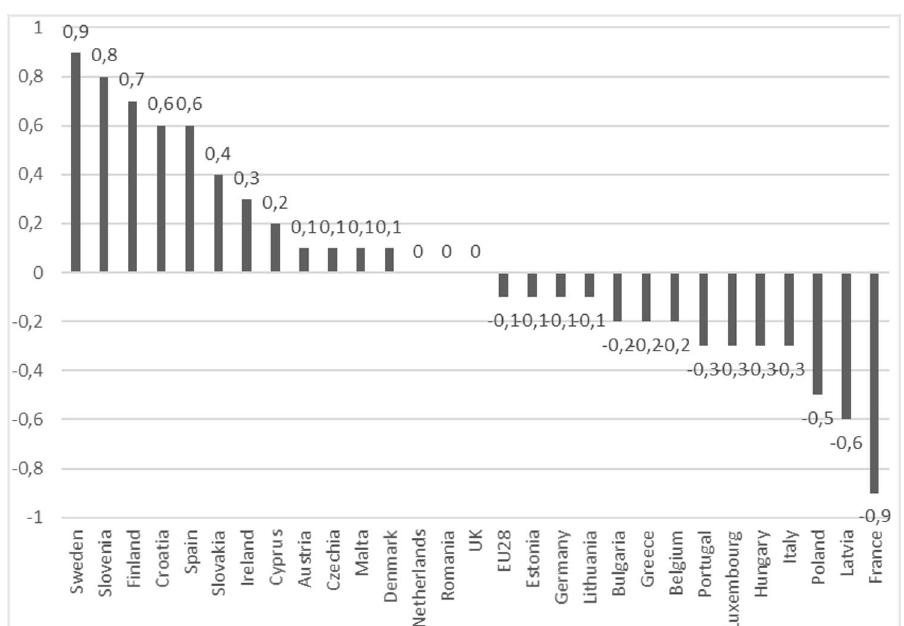
Figure 2. Gender gap (between females and males) in precarious employment in EU countries in 2019 * (pp based on the gaps between % of total employment in the group on females and males, 15–64 years); NACE Rev. 2 activity (Total – all NACE